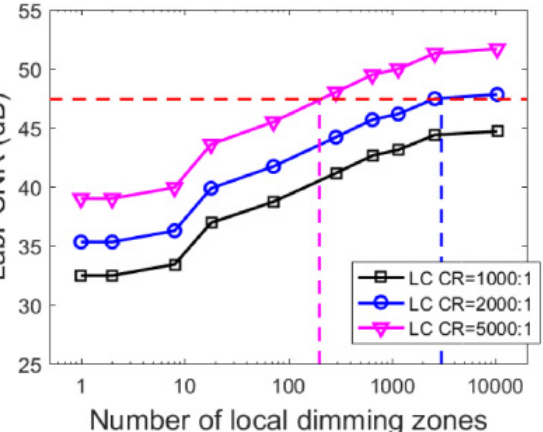
Figure 5. Simulated LabPSNR for different HDR display systems with various local dimming zone numbers and LC contrast ratios [25] .